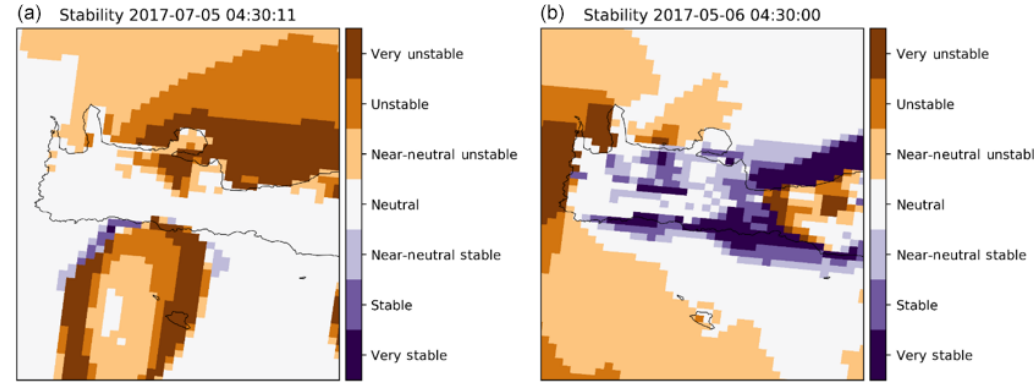
Figure 12. Stability class following Gryning et al. (2007) in WRF for the cases with winds from the north (a) and from the west (b) .